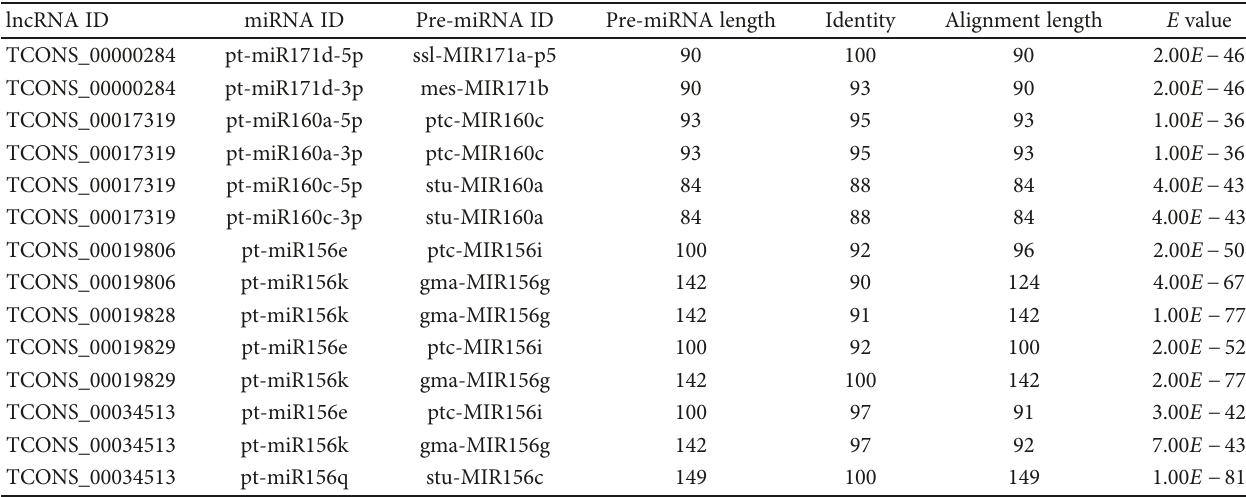
Table 2: lncRNAs acted as precursors of known miRNAs in